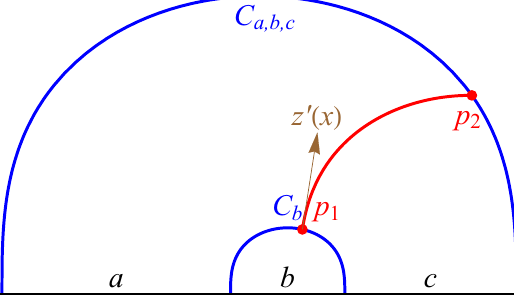
Figure 2 . One bipartite con(cid:12)guration can be speci(cid:12)ed by three parameters ( a; b; c ), where a and c are the width of two in(cid:12)nitely long strips,respectively, while b is the separation. C ## represents the minimum surface ending on con(cid:12)guration # [ #. The red curve z ( x ) is the geodesic connecting p 1 and p 2 , and the brown arrow represents the tangent vector z 0 ( x ) j p 1